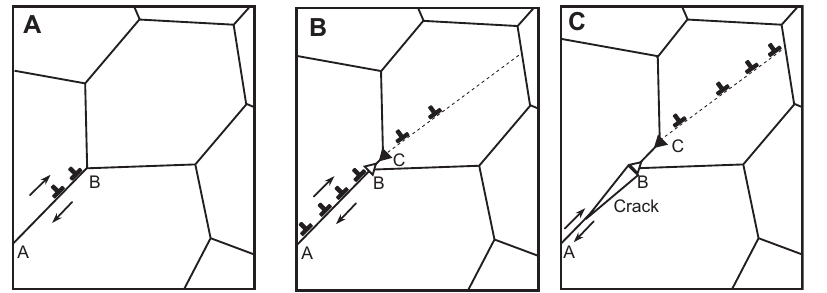
Figure 2 Intergrain sliding and its accommodation through lattice dislocation emission from triple junctions in a nanocrystalline solid. (A) Intergrain sliding (schematically marked by arrows) occurs through movement of grain boundary dislocations along grain boundary AB. Grain boundary dislocations are accumulated near triple junction B. (B) Grain boundary dislocations transform into lattice